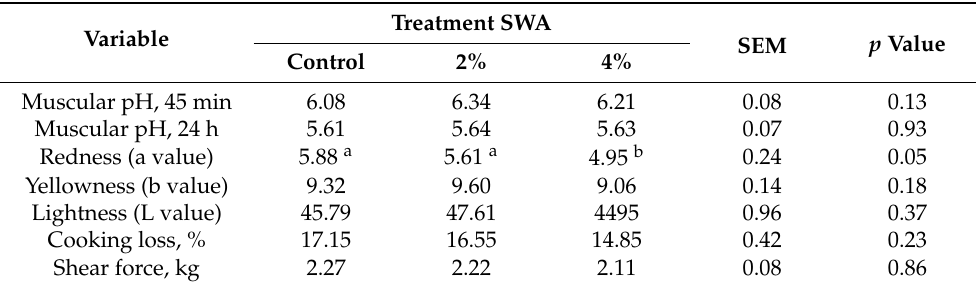
Table 2. Effects of the inclusion of seaweed additive (SWA) in the diet of fattening pigs on meat quality